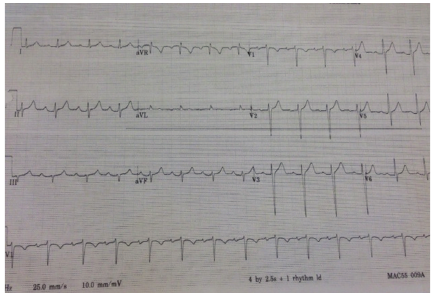
Figure 4: EKG showing sinus rhythm with resolution of the com- plete AV block and depicting sinus rhythm at a rate of 85 bpm with first-degree AV block and left anterior hemiblock.